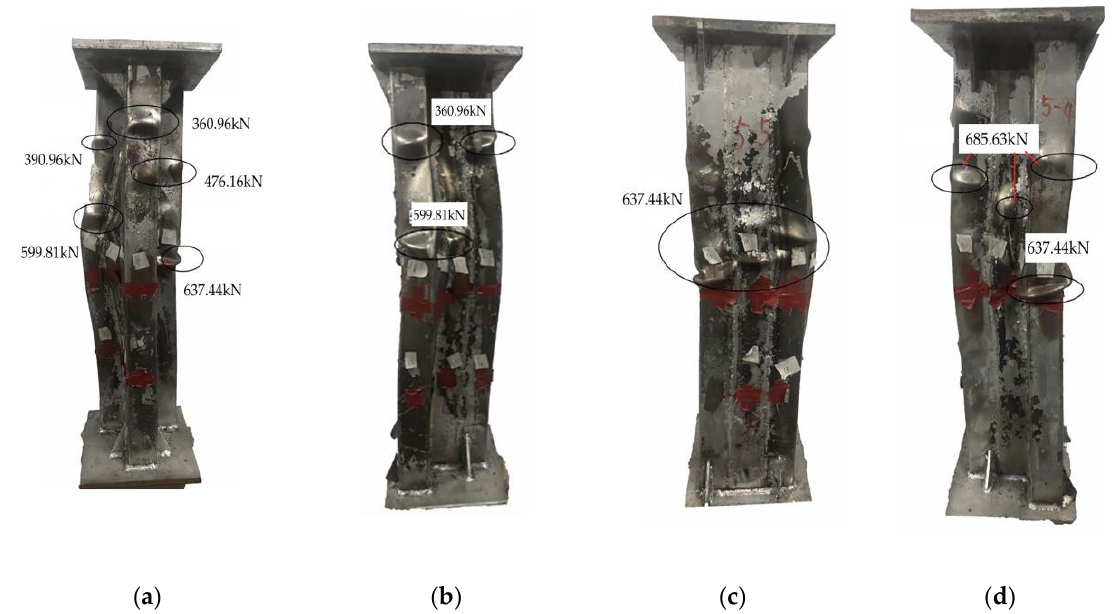
Figure 4. Deformation pattern of ( a ) the first surface; ( b ) the second surface; ( c ) the third surface; ( d ) the fourth surface of TA5-600 test specimen.